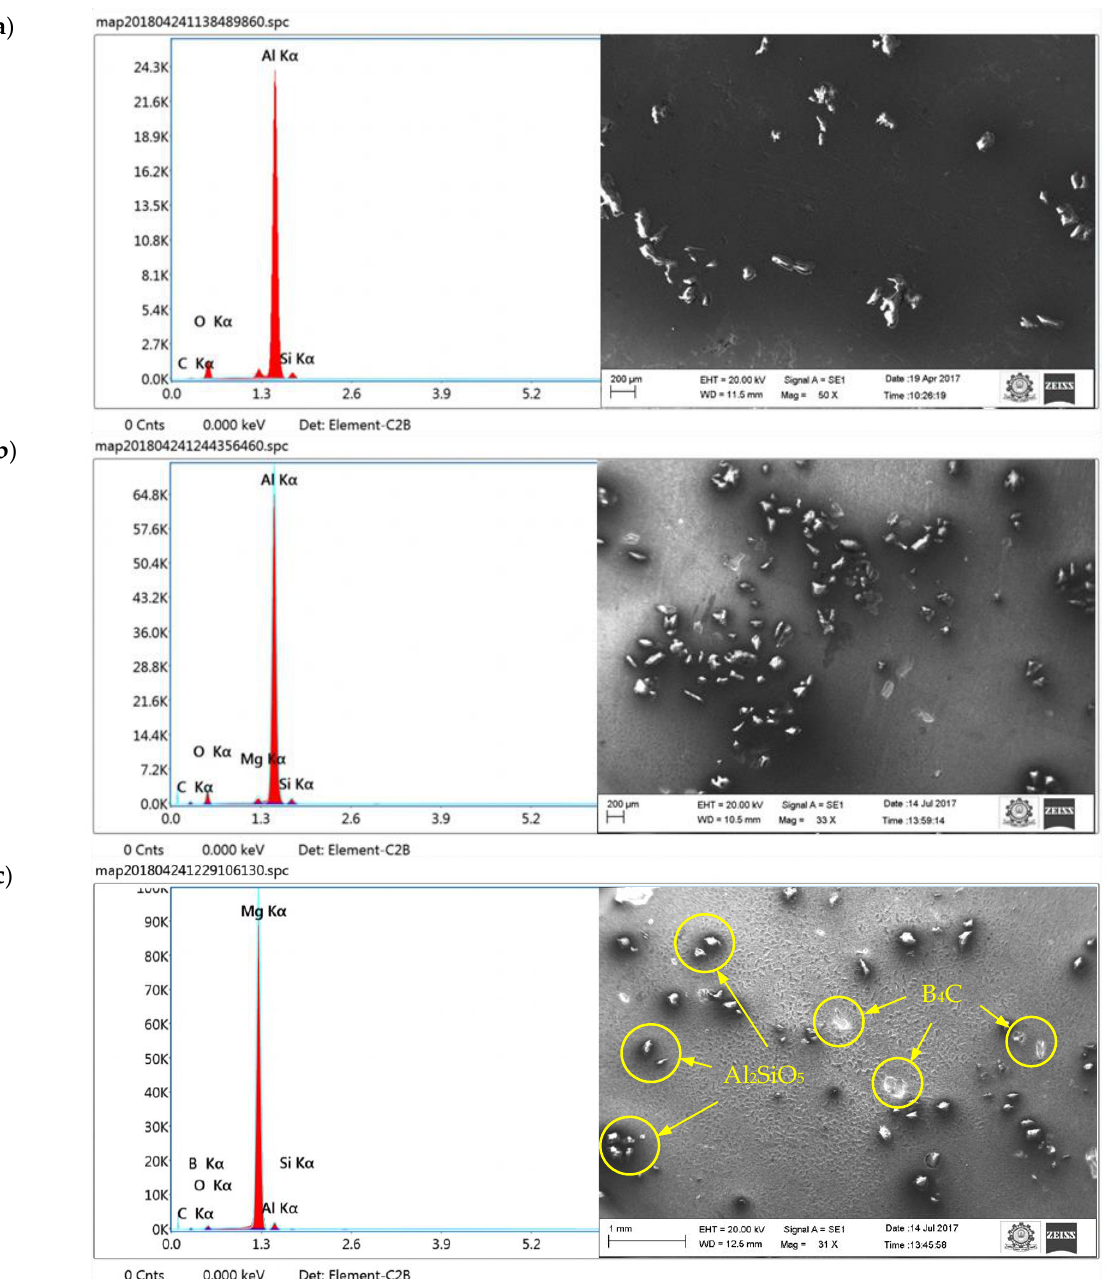
Figure 3. Surface morphology (SEM images) and EDX image: ( a ) 5 wt.% ( b ) 10 wt.% [35] and ( c ) hybrid composites.